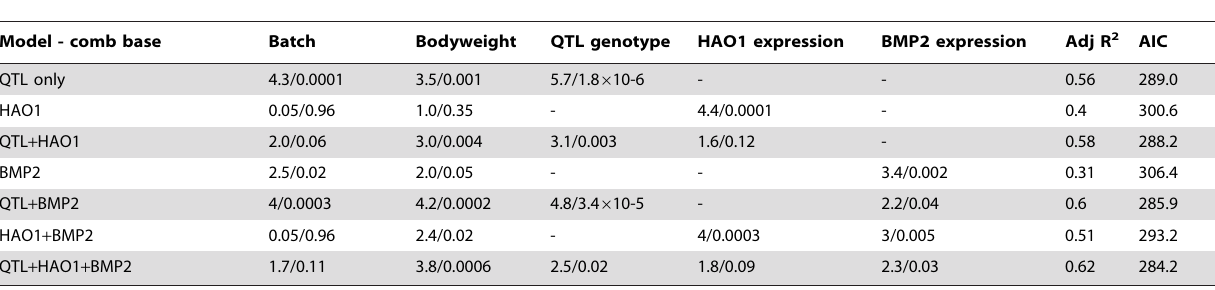
Table 1. General Linear Model results for gene expression and QTL effect on comb mass.